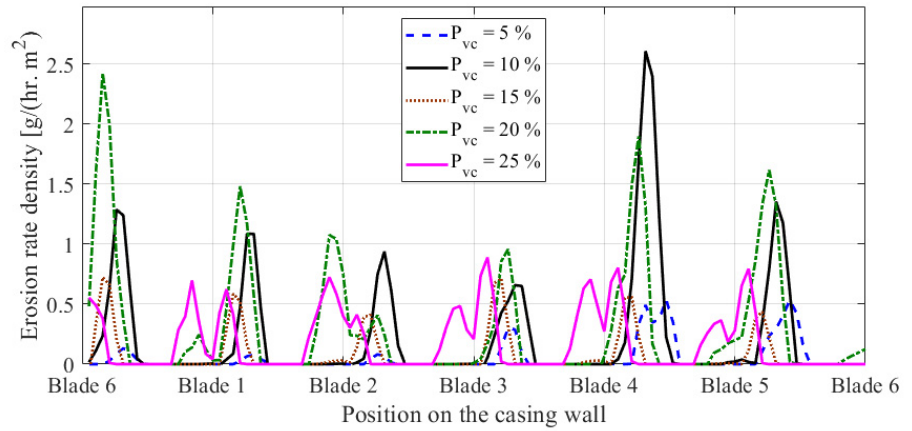
Figure 12. Variation of erosion density rate on the blade walls with different values volumetric concentration of the solid